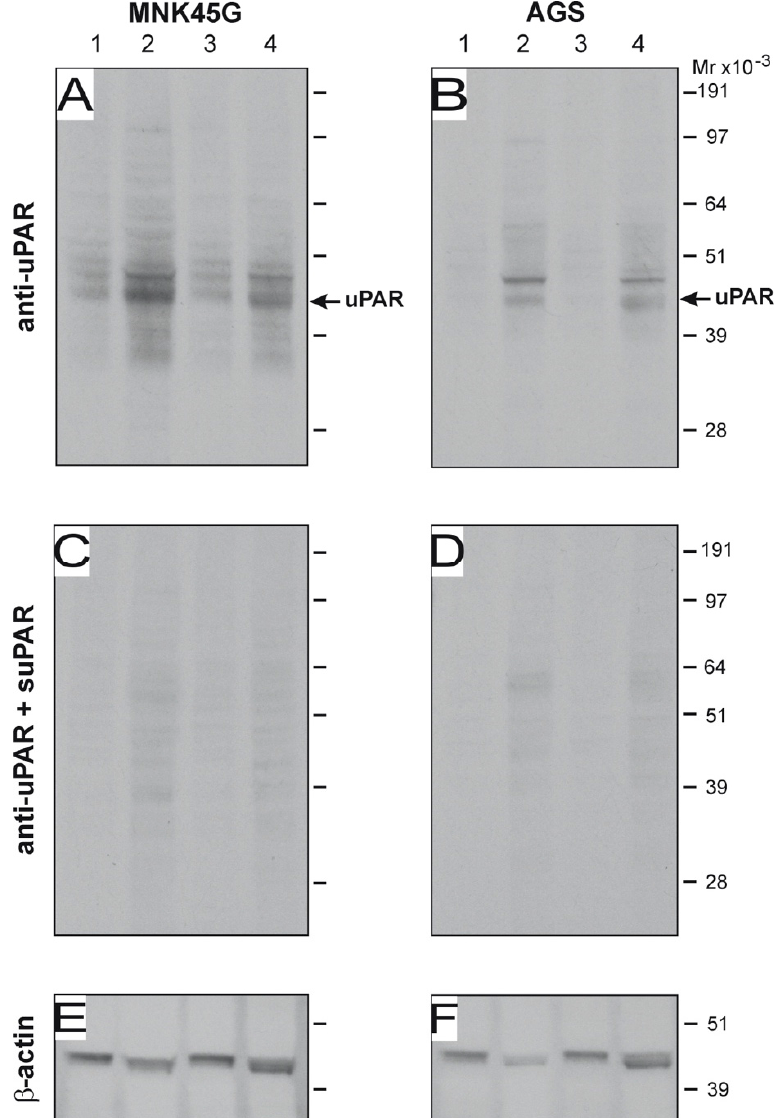
Figure 7. H. pylori -induced uPAR expression in gastric cancer cell lines in vitro. The gastric carcinoma cell-lines MNK45G and AGS (5 × 10 6 cells) were co-cultured with 1 × 10 9 CFU of H. pylori strains SS1 and J99 in serum-free RPMI media for 6 h at 37 °C. Western blotting of cells lysates and corresponding sham controls were developed with an anti-uPAR pAb ( A , B ), and the specificity of this detection is verified by pre-absorption with purified uPAR ( C , D ). After stripping, the equal loading was probed by staining for β -actin ( E , F ). Sham-treated control cells (lanes 1 and 3); cells co-cultured with SS1 (lane 2); cells co-cultured with J99 (lane 4). Su-PAR; soluble uPAR. Experiment performed in